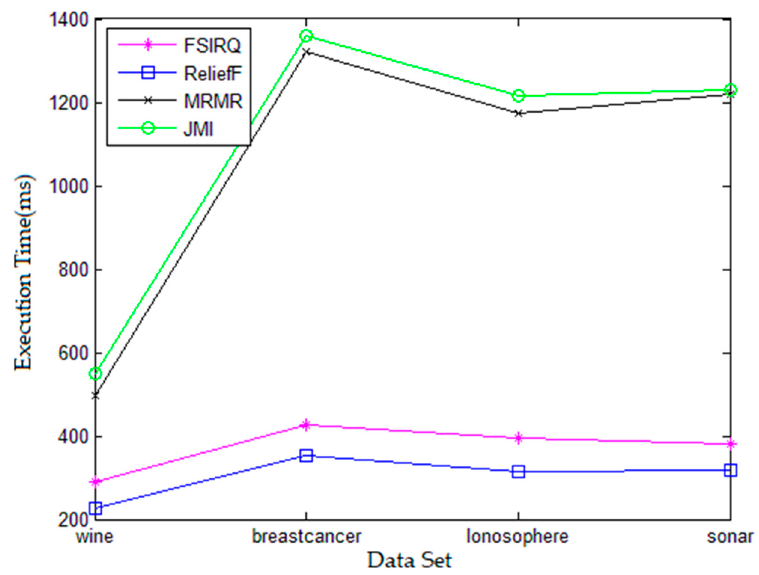
Figure 4. Comparison of Algorithm Execution Time.